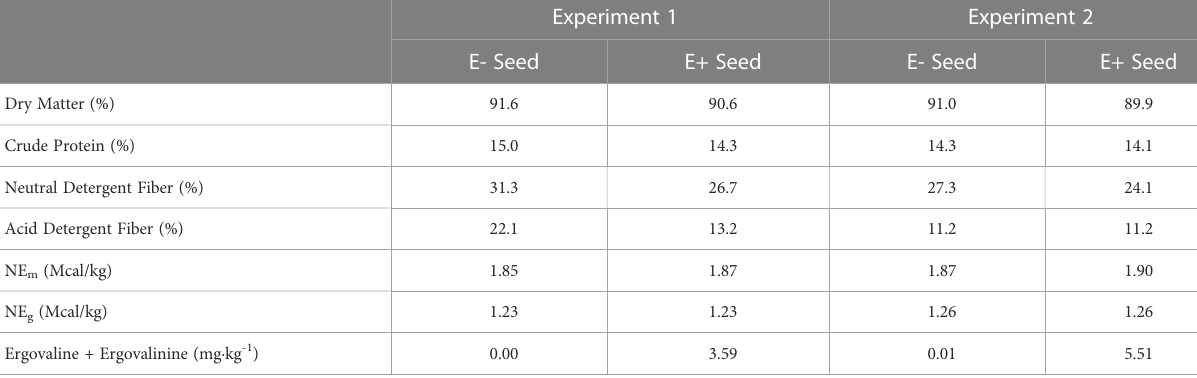
TABLE 2 Chemical composition of endophyte-infected and endophyte-free seed a